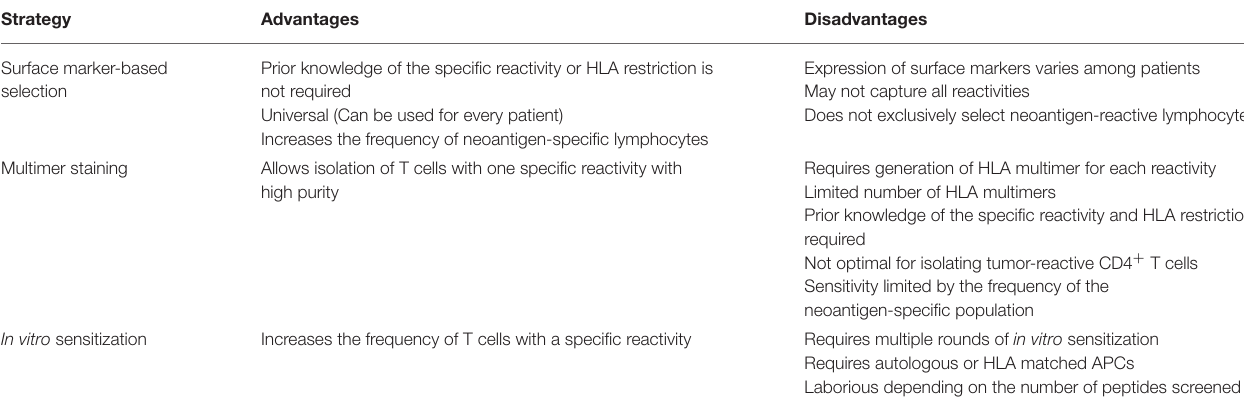
TABLE 4 | Strategies to enrich for neoantigen-specific lymphocytes. Strategy